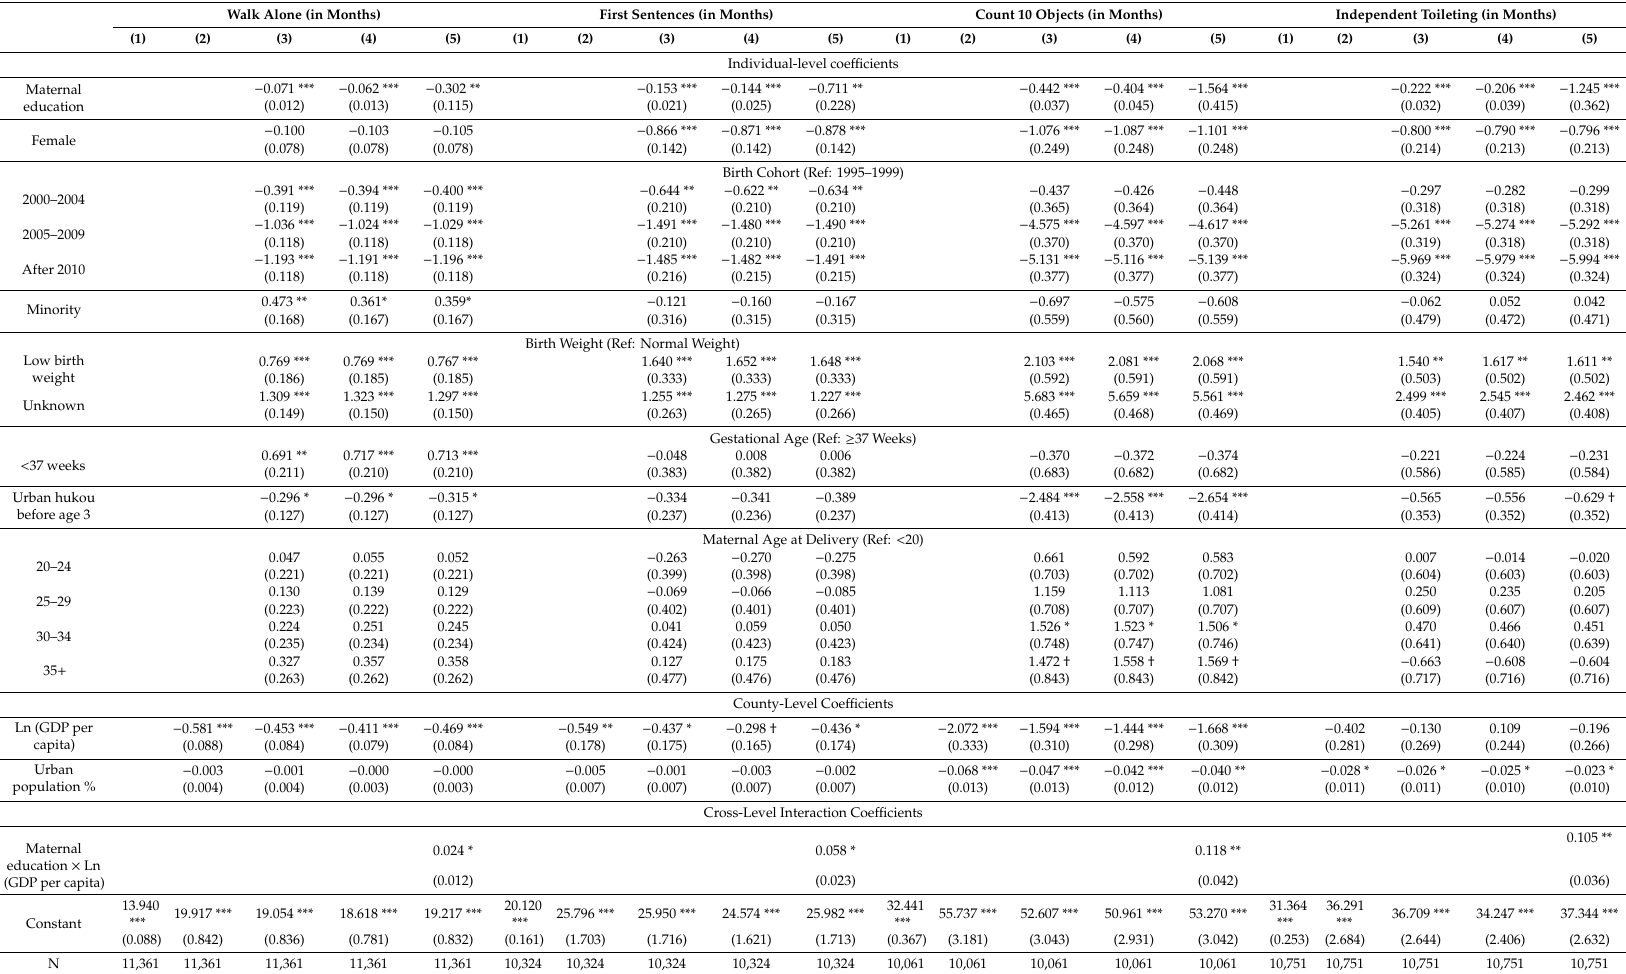
Table 2. Two-level Logistic Regression Models of Early Developmental Milestones on Individual and County-level Variables. WalkAlone(inMonths)